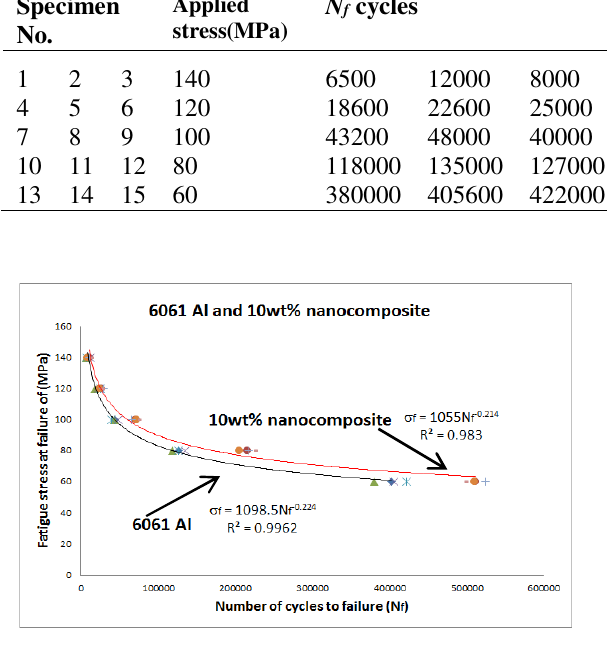
Fig. 2. Fatigue bending machine test . S-N curve results of Al6061 and Al6061/10 wt. % nanocomposite. Al6061 metal-matrix Al6061-10 wt% nanocomposite